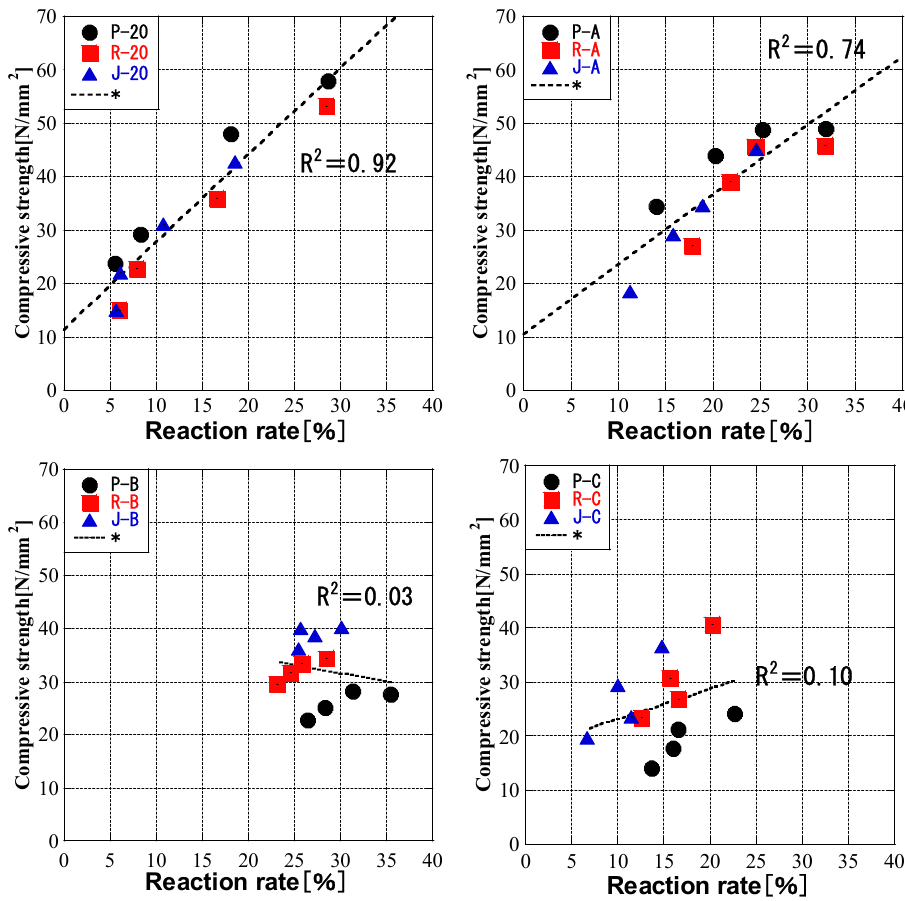
Figure 12. Relationship between compressive strength and FA reaction